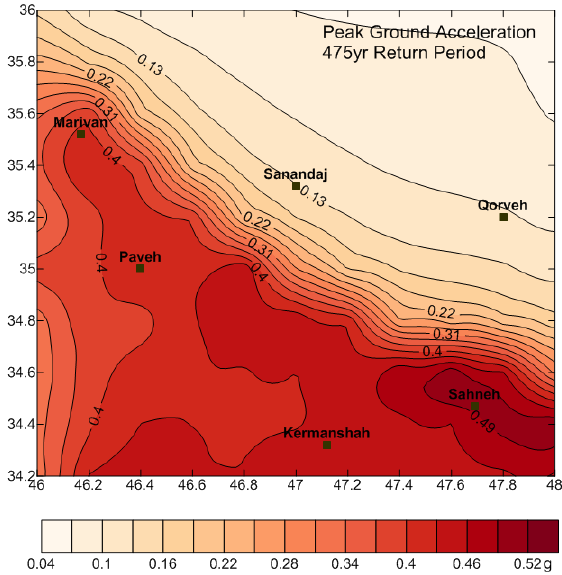
Figure 4. Seismic hazard map of the Kermanshah-Sanandaj region in terms of PGA for the 475-year return period.